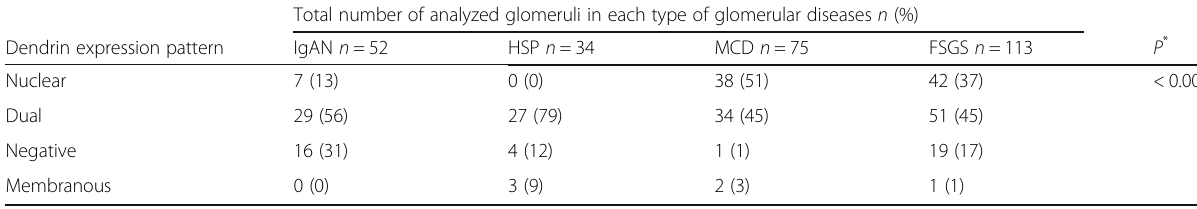
Table 5 Distribution of dendrin expression pattern in total number of glomeruli in analyzed glomerular diseases Total number of analyzed glomeruli in each type of glomerular diseases n (%) Dendrin expression pattern IgAN n = 52 HSP n = 34 MCD n = 75 FSGS n = 113 P